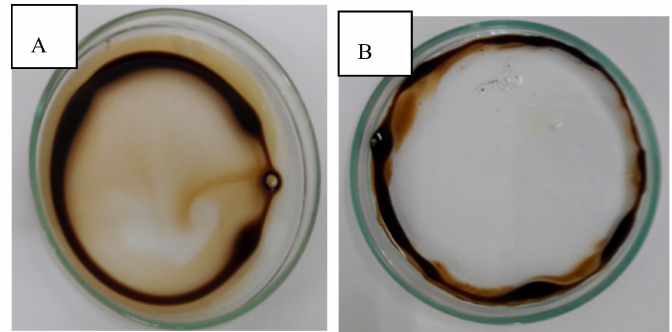
Figure 5. Dispersion of burned engine oil in water. ( A ) Commercial detergent as the control, and ( B ) The bioemulsifier produced by Bacillus subtilis